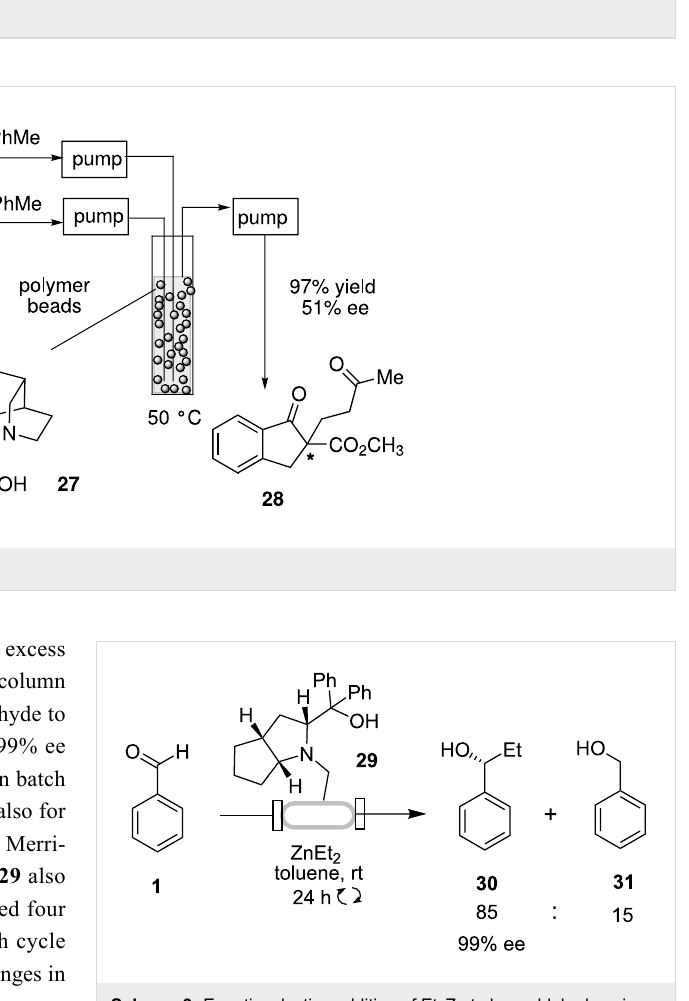
Scheme 7: α-Chlorination of acid chlorides in flow.